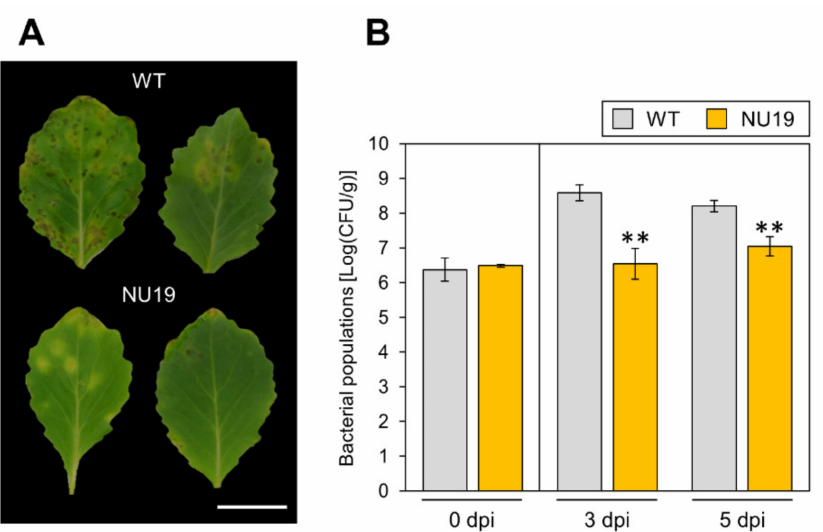
Figure 1. Disease symptoms ( A ) and bacterial populations ( B ) on cabbage leaves dip-inoculated with Pseudomonas cannabina pv. alisalensis KB211 WT and NU19. Cabbage plants were dip-inoculated with 5 × 10 7 CFU/mL of inoculum containing 0.025% Silwet L-77. The bacterial populations in the plant were evaluated at 0, 3, and 5 dpi. The leaves were photographed at 5 dpi. Scale bar shows 2 cm. Vertical bars indicate the standard error for at least three independent experiments. Asterisks indicate a significant difference from the Pcal WT in a t -test (** p <